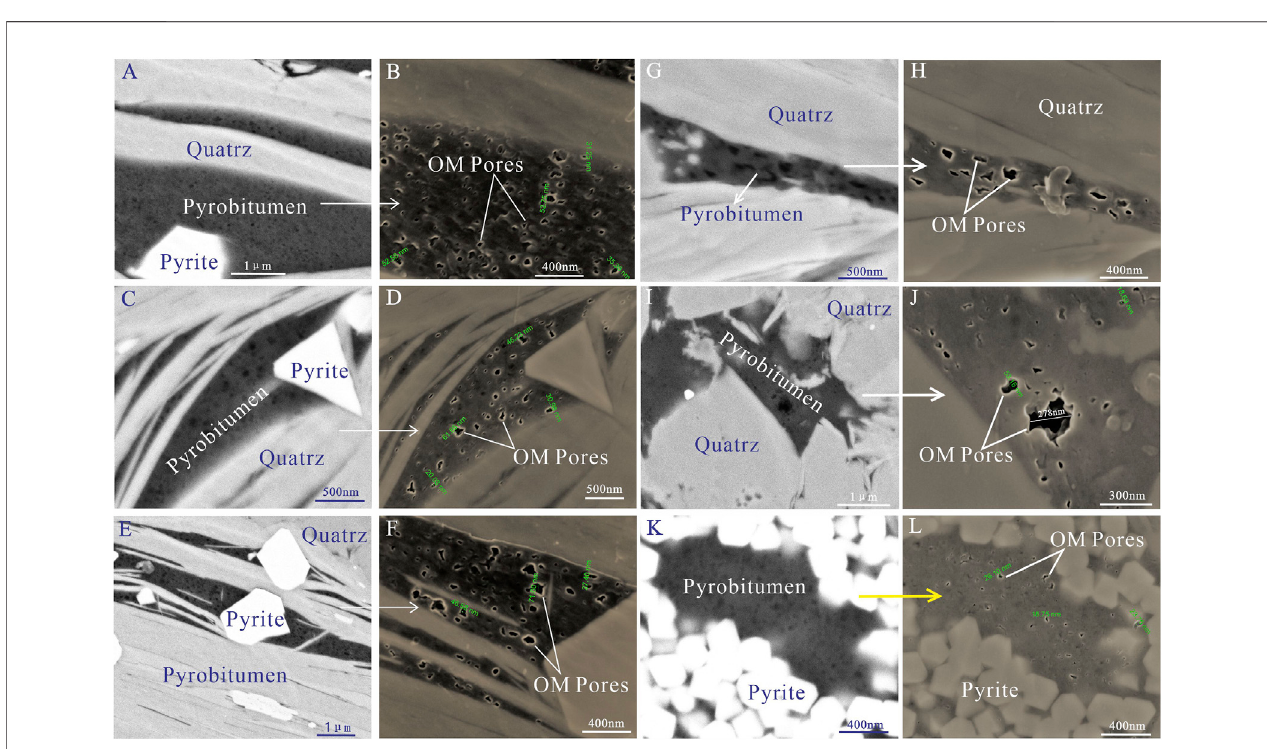
FIGURE8 | OM pore microscope characteristics of theLongmaxi shale samplesin Hunan (SY1 well, 1,569.2 m). OM pores with small sizes(20 – 100 nm) are seen in the pyrobitumen.OM pores are irregular in shape.